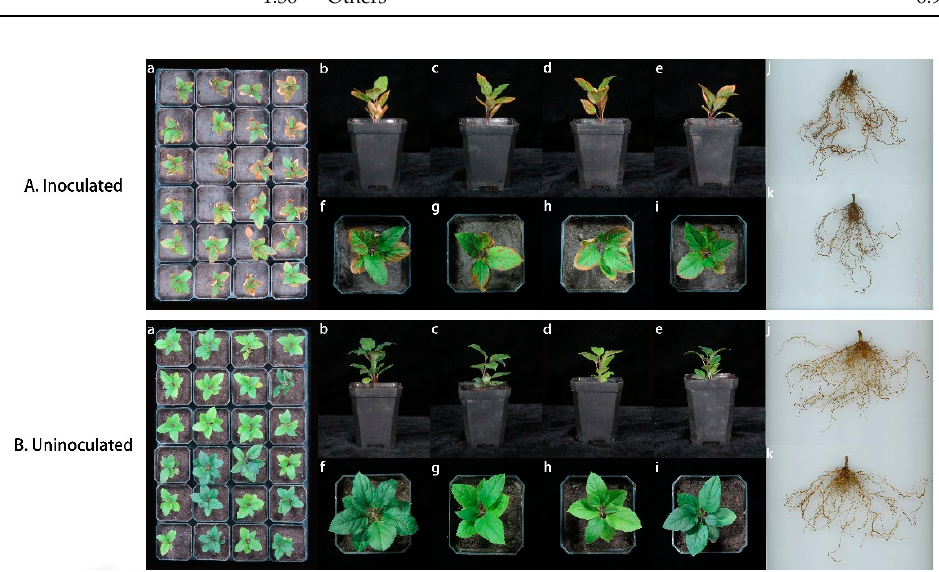
Figure 4. Effect of M9T337 inoculated with the Fusarium solani isolate HBH 08 ( A ) and without the Fusarium solani isolate HBH 08 ( B ). A: aboveground ( a – i ) and root system ( j , k ) incidence of M9T337